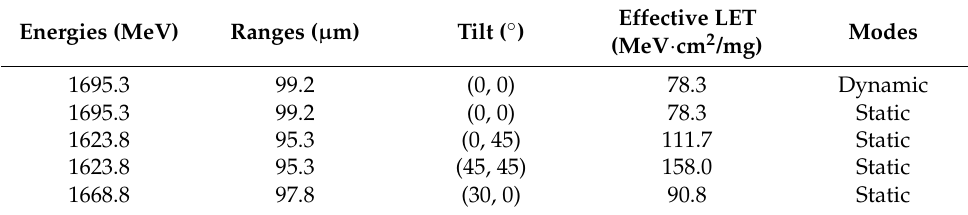
Table 1. The parameters of 181 Ta ions and irradiation